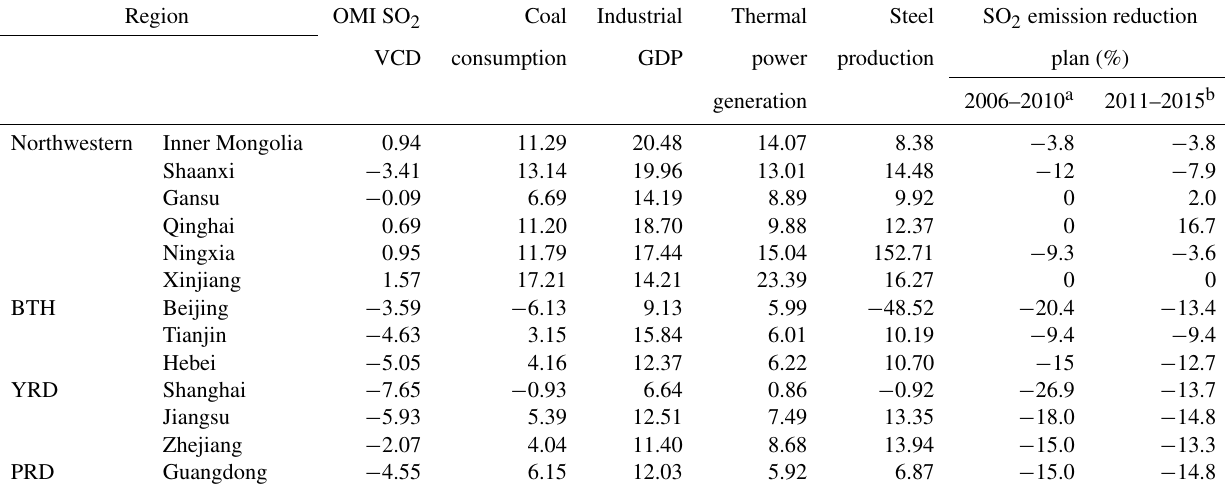
Table 1. Annual growth rate for OMI SO 2 VCD and economic activities for individual provinces and municipality during 2005–2014 (%yr − 1 ) , and SO 2 emission reduction plan during the 11th and 12th 5-year-plan periods